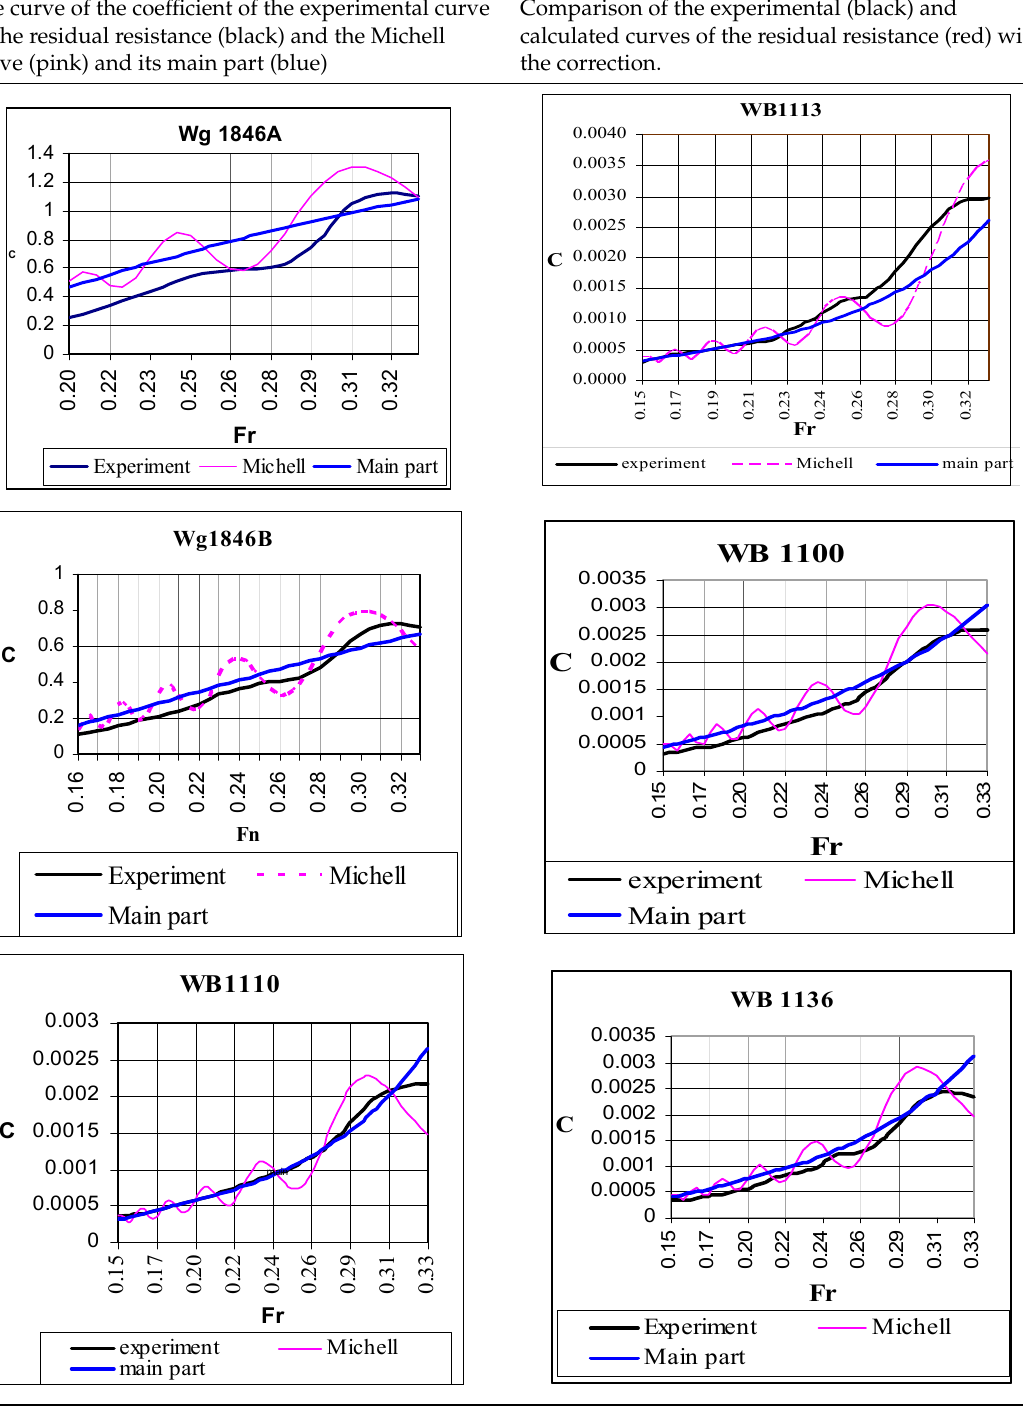
Comparison of the experimental (black) and